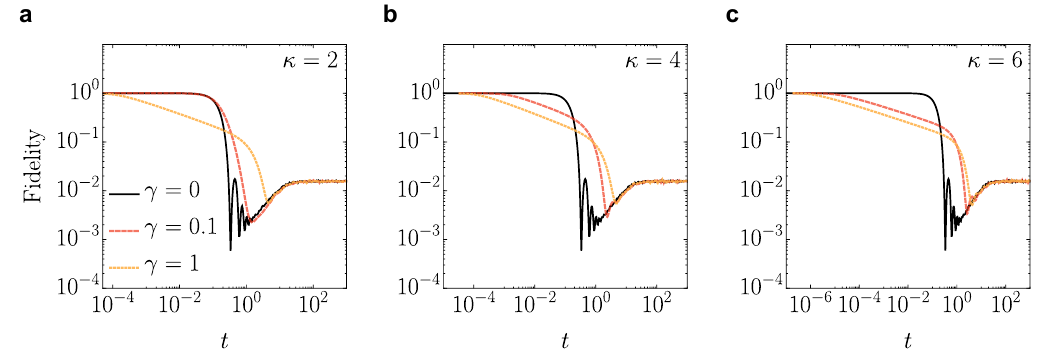
Figure 6 . Correlation hole shrinking for different non-Hermitian deformations. Fidelity between initial and time evolved infinite inverse temperature coherent Gibbs state under the BNGL dynamics of L ( κ ) , for even κ and characteristic values of the dephasing strength γ . Three different deformations for κ = 2 , 4 , 6 are averaged over a sample of 1000 GOE(2 6 ) undeformed Hamiltonians H 0 with σ = 1 . we show the Hamiltonian averages of 1000 Hamiltonians, sampled from GOE(64) for infinite temperature β = 0 and different values of the dephasing